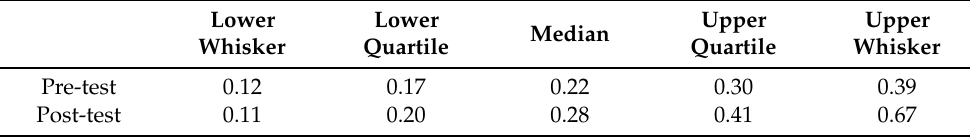
Table 4. Boxplot diagram